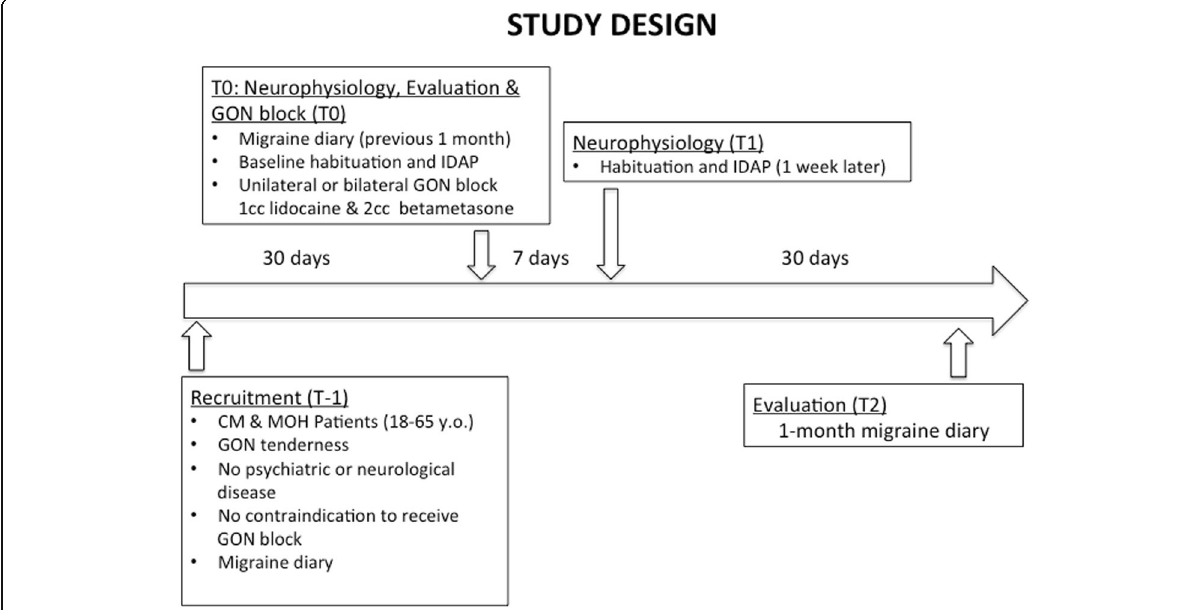
Fig. 1 Study design. Patients were recruited at T0. After 1 month of clinical evaluation, we performed neurophysiological recordings (habituation and IDAP) prior to GON anaesthetic block. Early neurophysiological changes were collected after a week and clinical revaluation was planned at 30